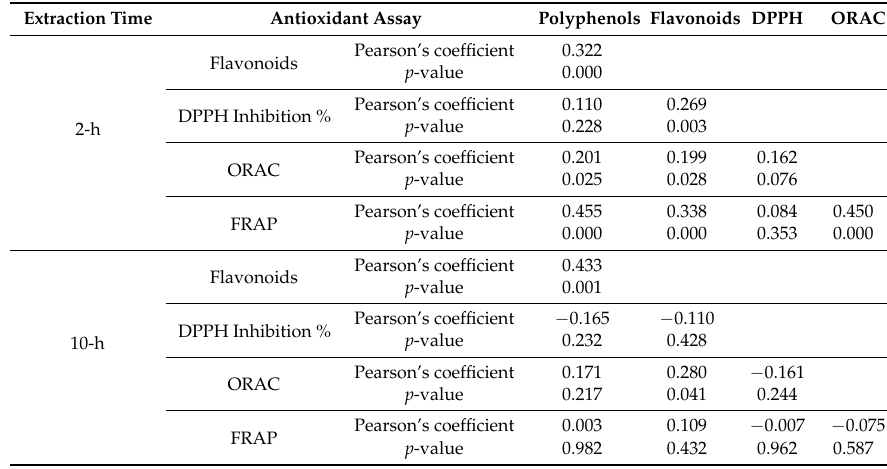
Table 4. Pearson’s Overall Correlation between the Antioxidant Assays in the 2-h Extraction ( p < 0.05 indicates